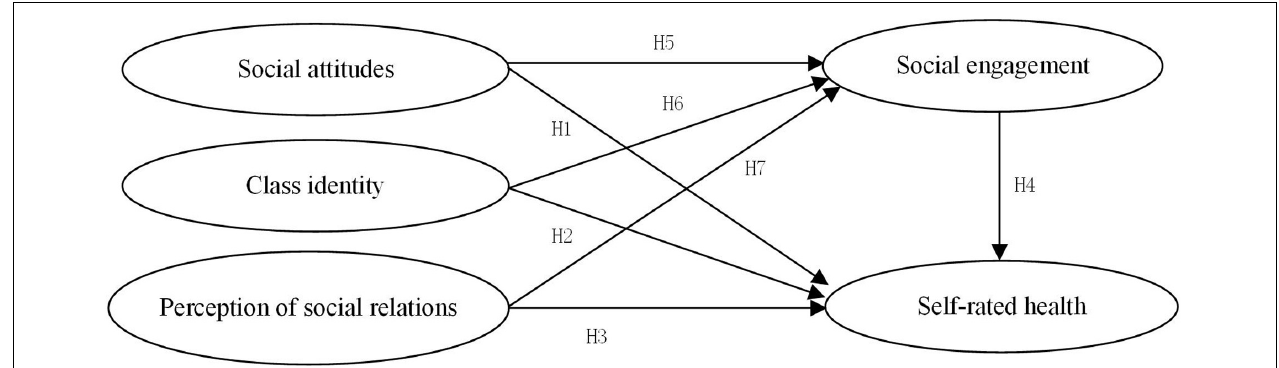
FIGURE 1 | Path hypothesis